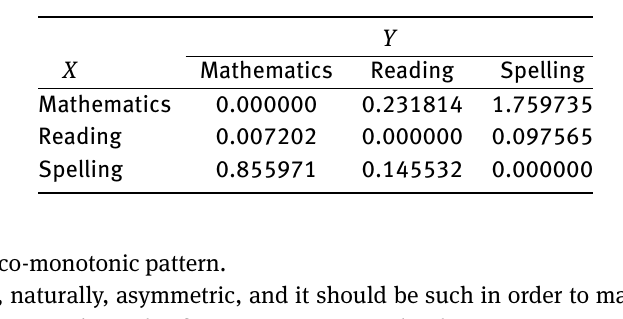
Table 3: Conditional-mean based LOC matrix (entries multiplied by 1, 000